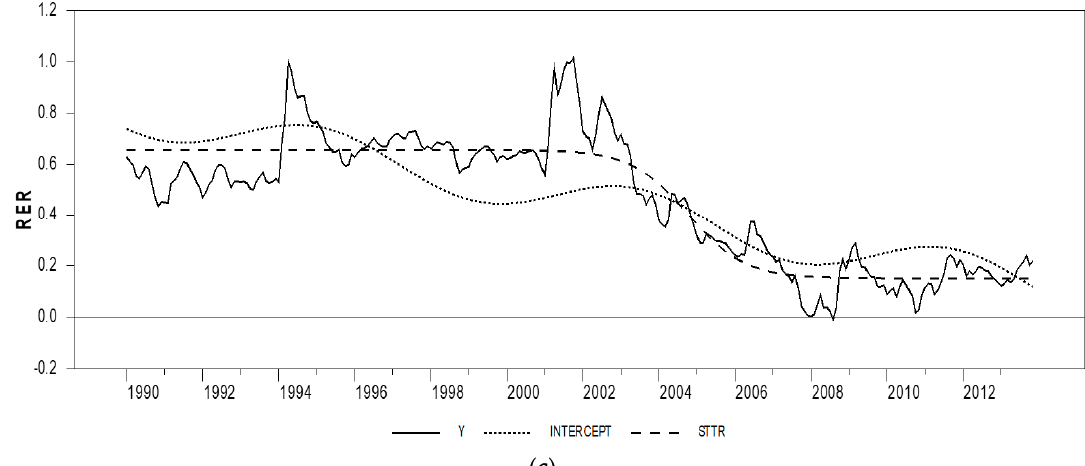
Figure 4. Plots of the Turkey/US real exchange rate (RER) series. ( a ) The Fourier intercept k = 1 and the ST trend–Model A; ( b ) residuals from de-trending with Fourier intercept k = 1 and the ST trend–Model A; ( c ) the Fourier intercept k = 1 and the ST trend–Model A. Table 8. Empirical application to the Turkey/US real exchange rate over